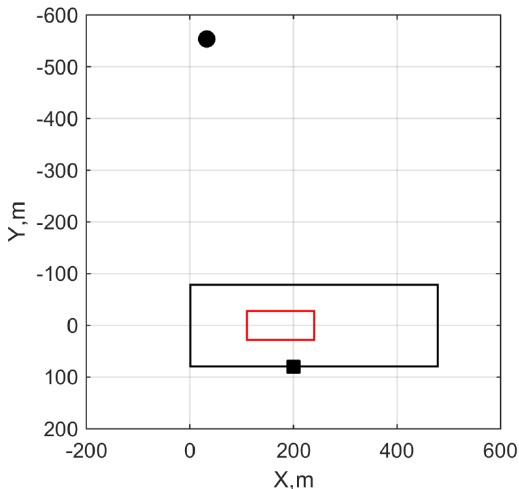
Figure 4. Geometry of the computation grid. The core domain (black rectangle) covers the anomalous body (red rectangle) and receiver position (small black square). The small black circle depicts position of the transmitter.